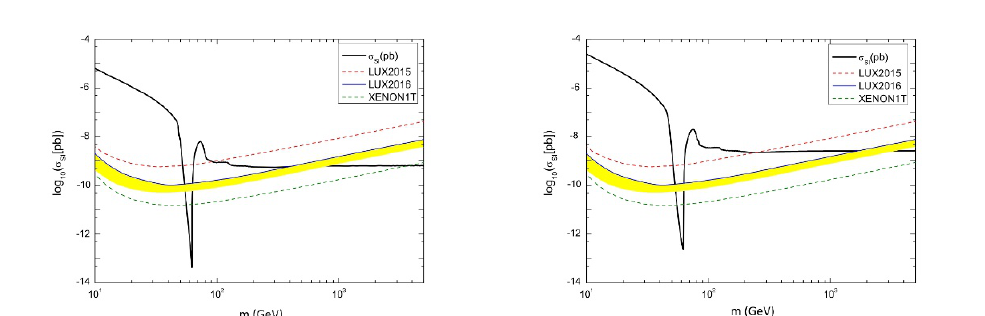
Figure 1 . DM-nucleon scattering cross section (cid:27) SI as the function of DM mass in the model A ( left ) and model B ( right ), respectively. The dependence of (cid:27) SI on Yukawa coupling constant (cid:20) is eliminated by the constraint from DM relic abundance as shown in table 1. Curves of LUX 2015 (red), LUX 2016 (blue) and Xenon1T (green) [36] are shown simultaneously, and the yellow band refers to 2 (cid:27) deviation to their central values that were chosen by authors in refs. [38,